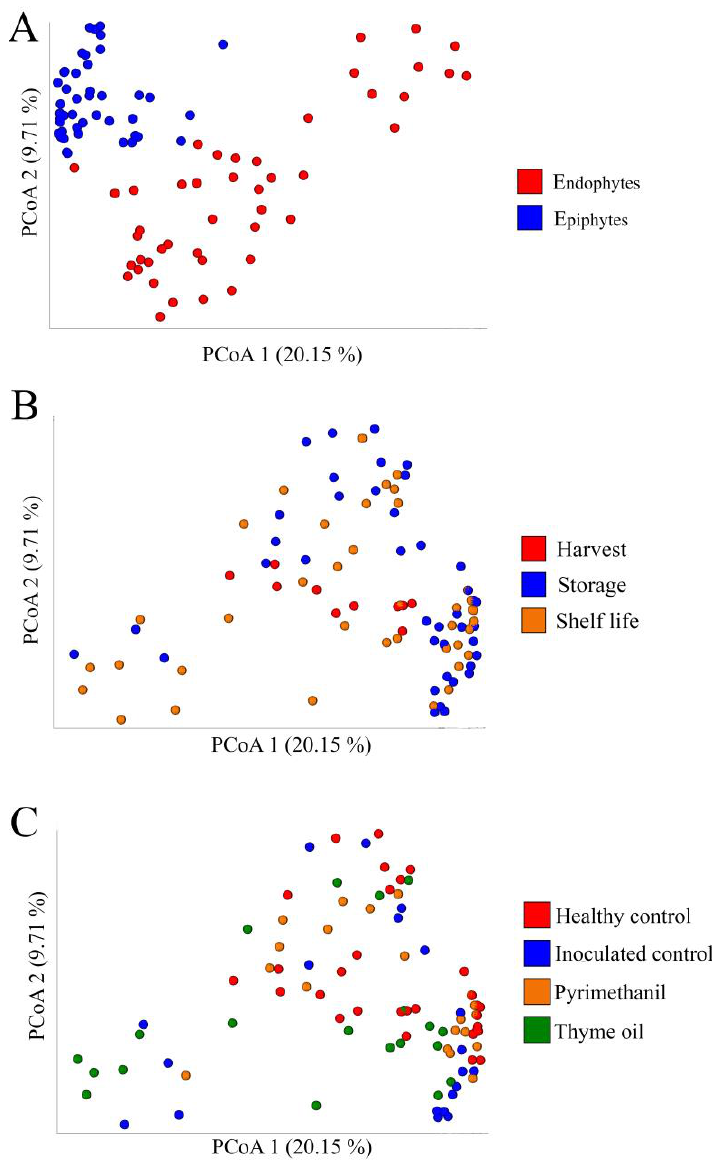
Figure 3. PCoA analysis of Bray-Curtis dissimilarity index results, based on tissue (A), time point (B), and treatment (C).